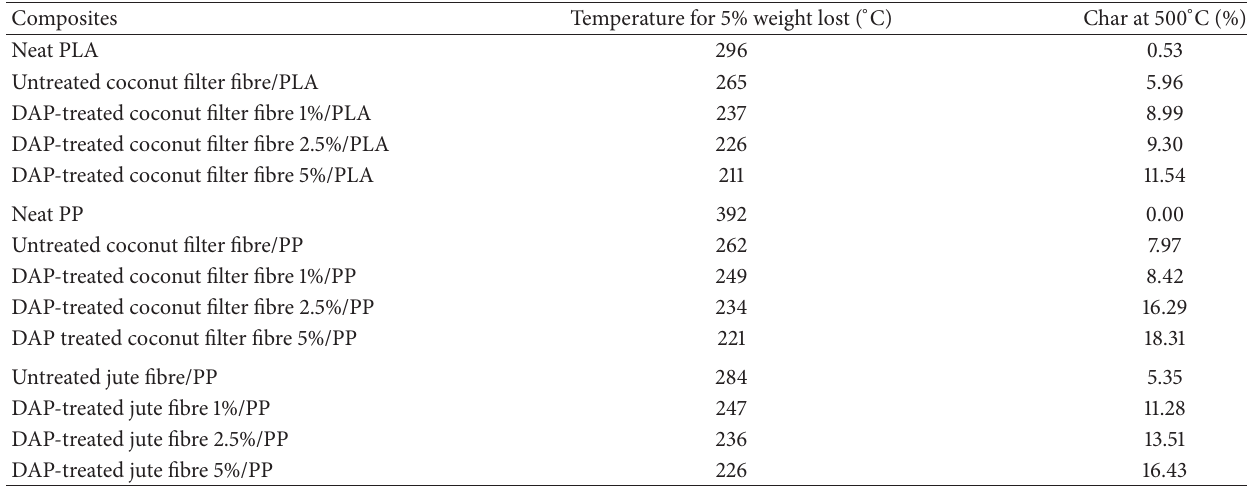
Table 4: TGA date of composites [47].